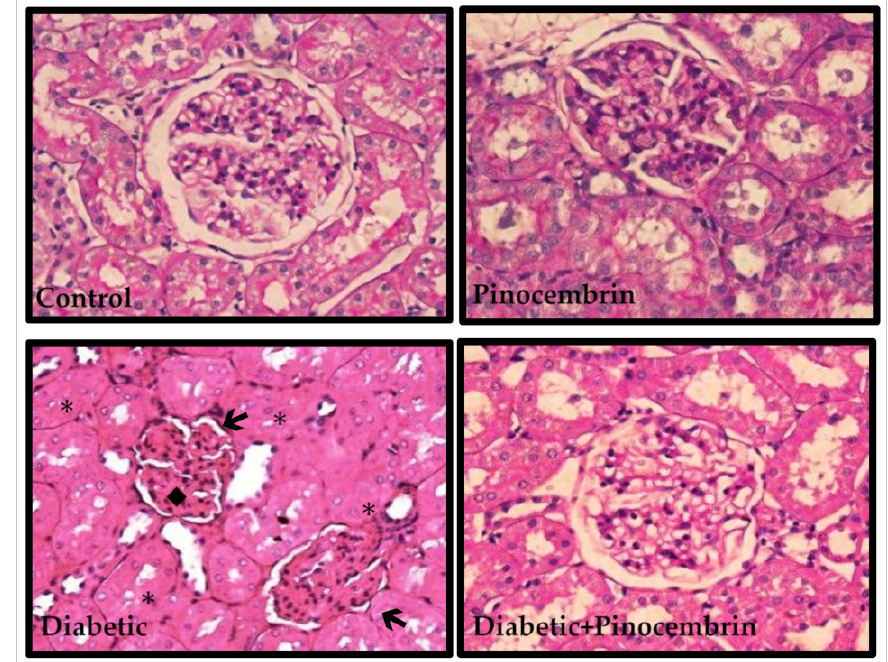
Figure 4. Representative photomicrographs of glomerulus structure in the preventive scheme. Renal structure stained with PAS. Symbols ( ← ) Marked lobulation of the glomerulus, ( (cid:7) ) extracellular matrix accumulation, (*) occluded